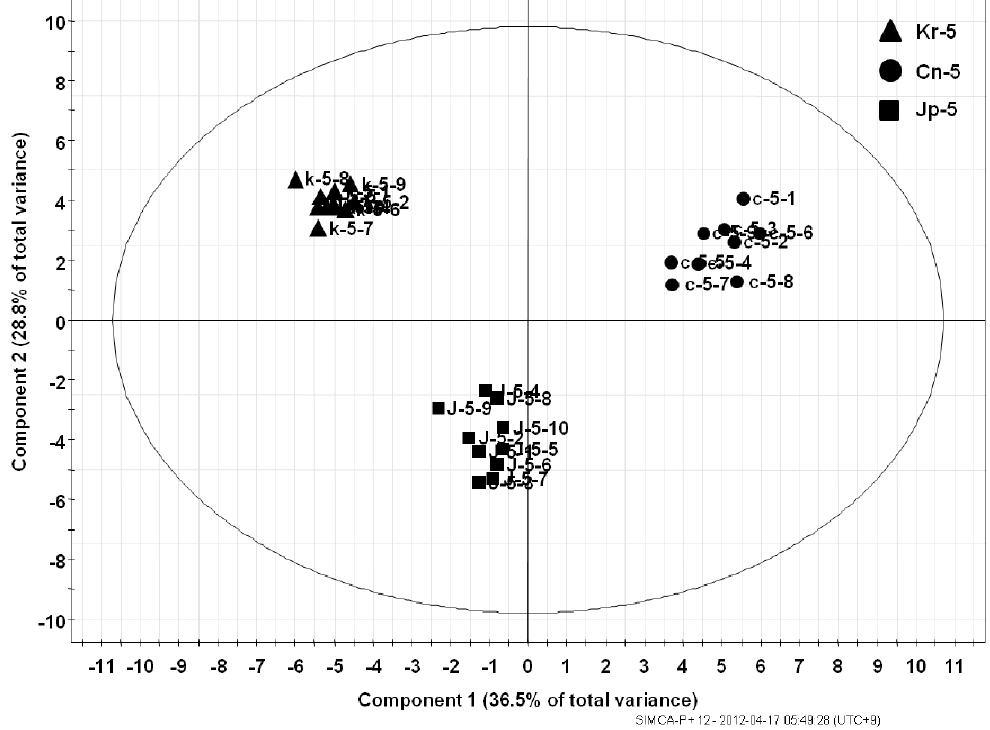
Figure 3. PCA score plot representing analysis derived from ESI negative ion mode. Separation is depicted by the PCA score plot revealing the significant influence of cultivation area ( i.e. , Korea, China and Japan) in determining dissimilarities.